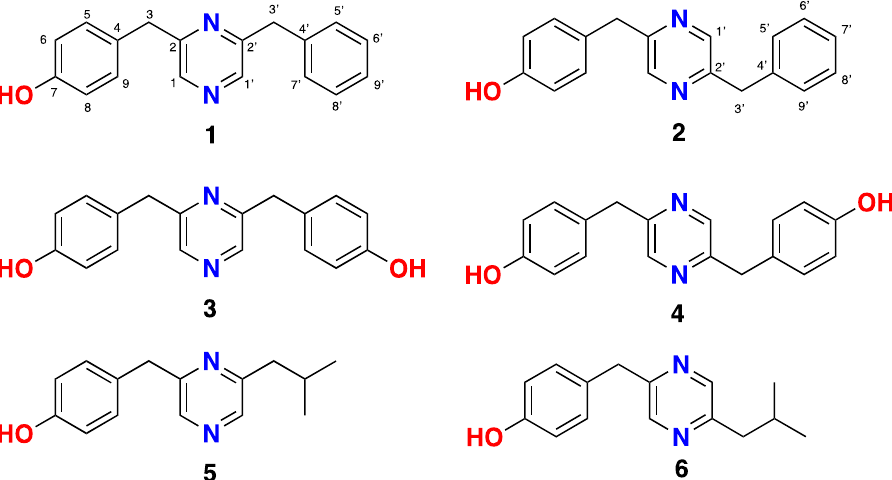
Figure 1. Lentzeacins A-E ( 1 – 3 , 5 , 6 ) and actinopolymorphol C ( 4 ) from Lentzea sp .